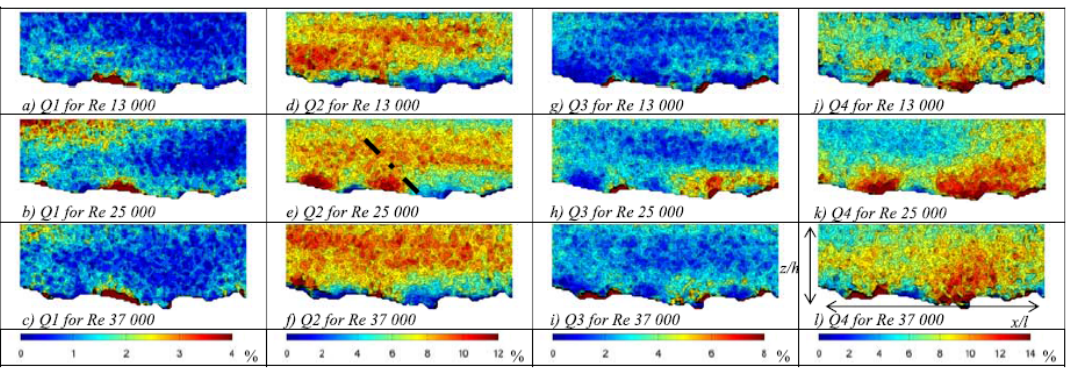
Figure 11. Flow structures as examined with the quadrant analysis: ( a – c ) first quadrant (outward intersections); ( d – f ) second quadrant (ejections); ( g – i ) third quadrant (inward intersections); and ( j – l ) fourth quadrant (sweeps) (data extracted from Hardy et al.